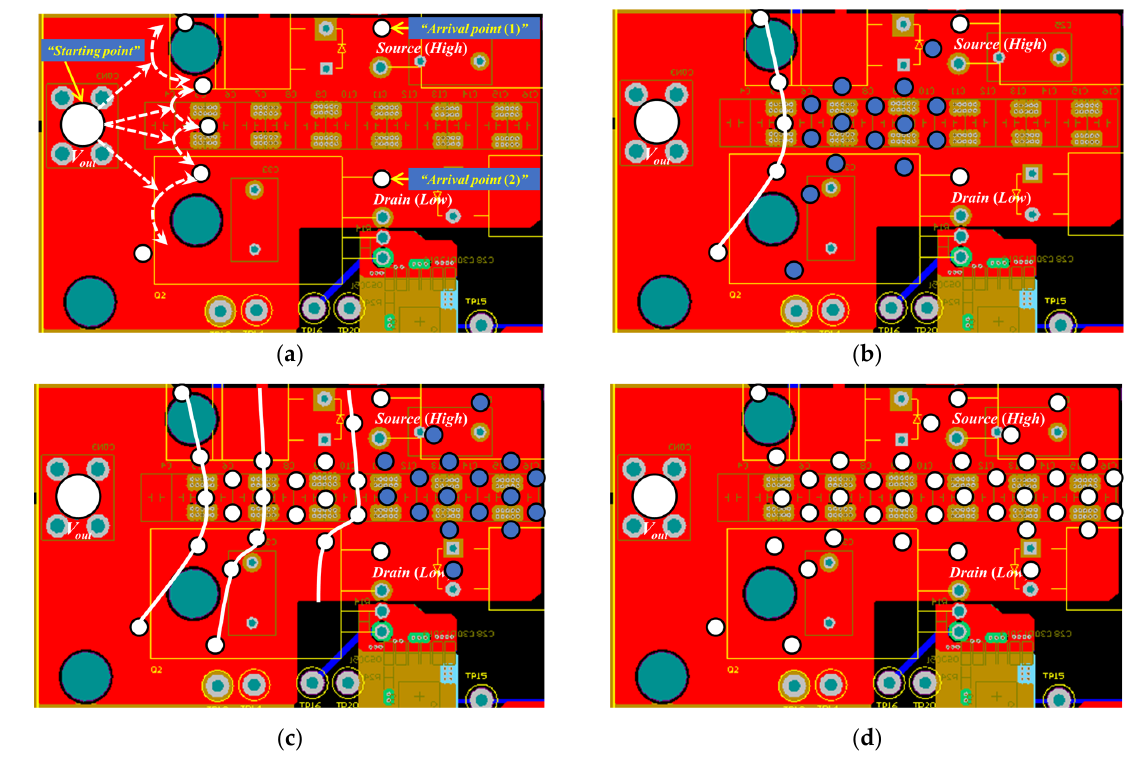
Figure 6. Lumped parameter modeling sequence at top layer. ( a ) Region 1. ( b ) Region 2. ( c ) Region 3. ( d ) Selected result.